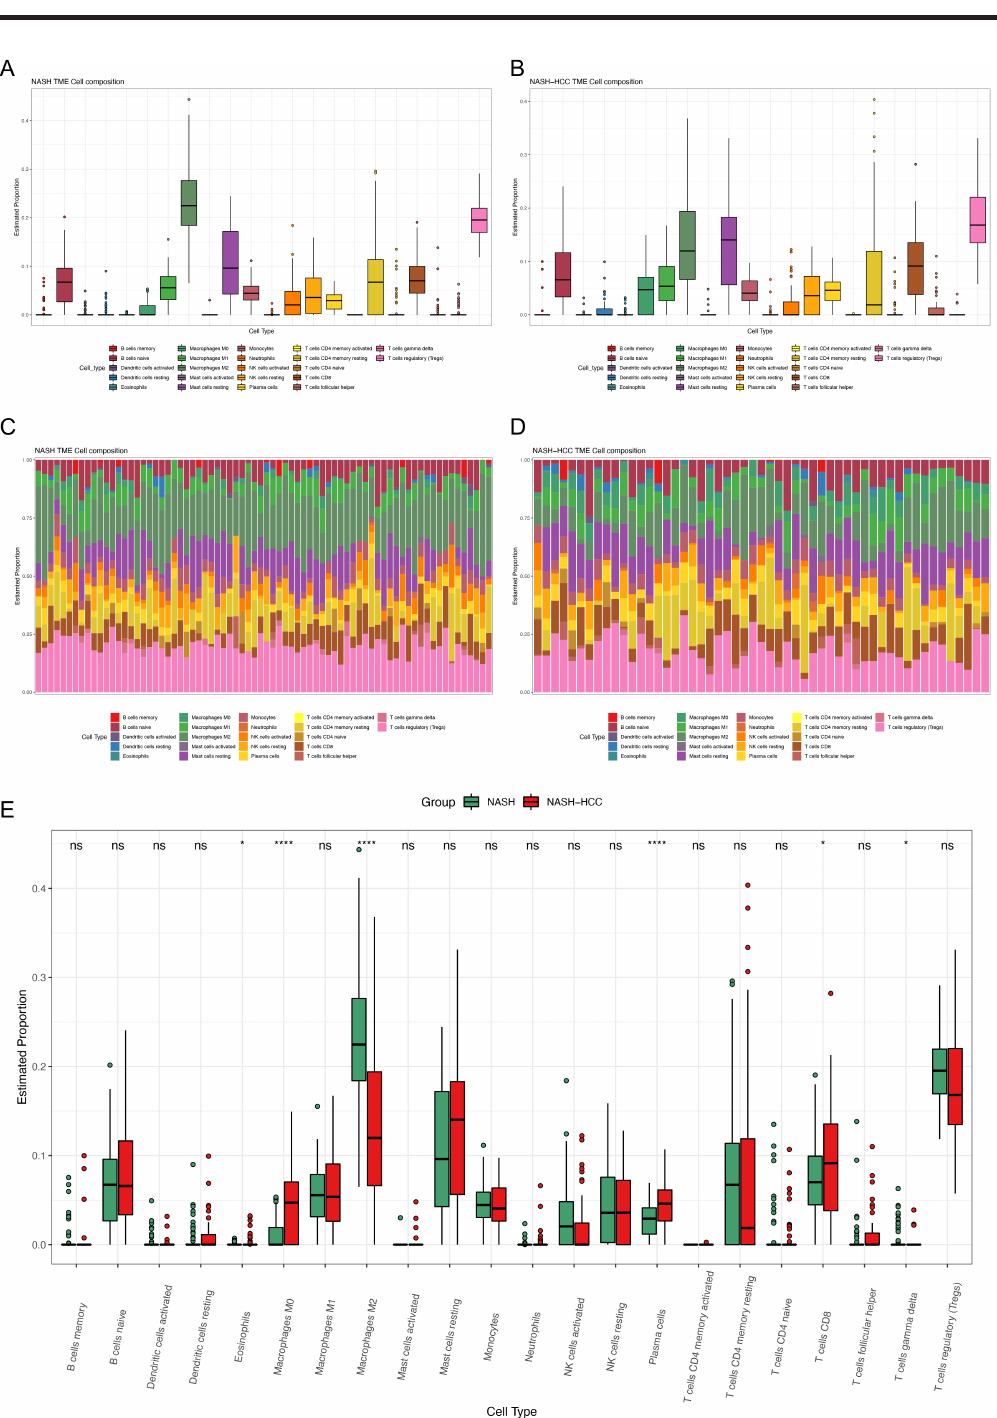
Figure 3. Immune cell infiltration analysis showed the different proportion of M0 macrophages, M2 macrophages, plasma cells, and CD8+T cells between NASH-HCC tissues and NASH tissues. (A) Composition of 22 immune cells in 74 NASH tissues. (B) Composition of 22 immune cells in 53 NASH-HCC tissues. (C) Fractions of 22 immune cells in 74 NASH tissues. (D) Fractions of 22 immune cells in 53 NASH-HCC tissues. (E) Comparisons of 22 immune cells between NASH tissues and NASH-HCC tissues. HCC, hepatocellular carcinoma; NASH, non-alcoholic